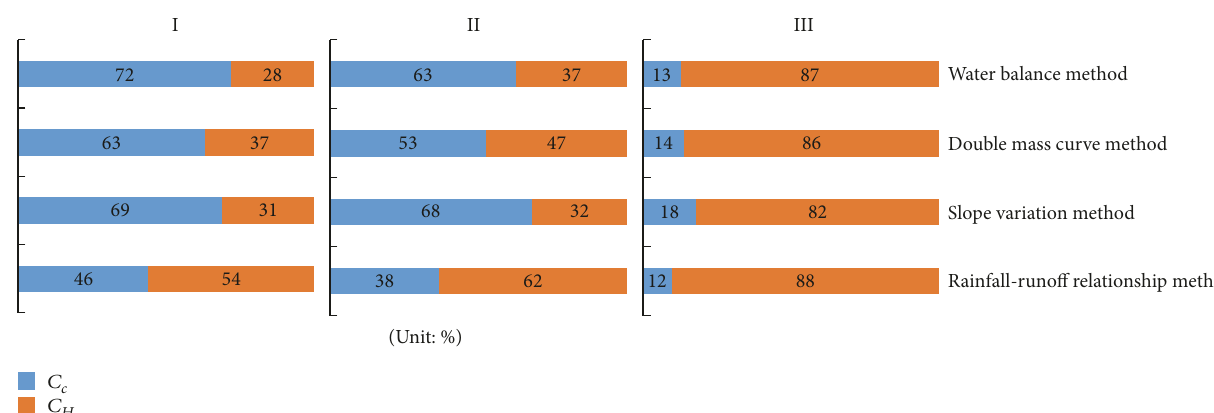
Figure 4: Contributions of climate changes and human activities to runoff in the different methods at upstream, midstream, and downstream.